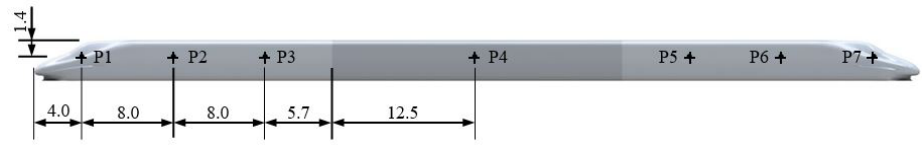
Fig. 8. Layout of monitoring points of type B train